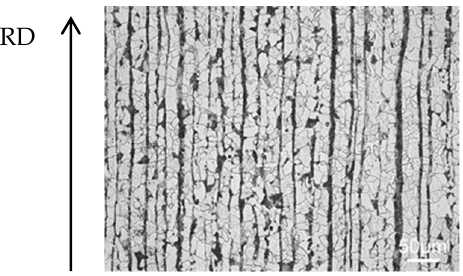
Figure 1. Specimen microstructure.